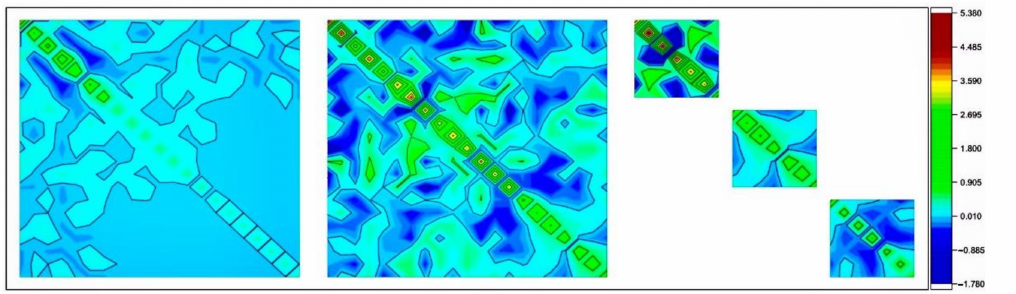
Figure 6. Element values of the covariance matrix after Z-transformation for S1 and S2 and S3 from left to right, respectively. S3 has three blocks for EWL, WL and B1 sequentially.